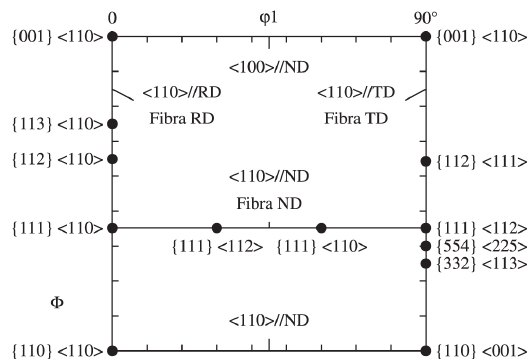
Figure 13. ODF section with Φ2 = 45 ° showing the position of the major components of texture along the RD, TD and ND